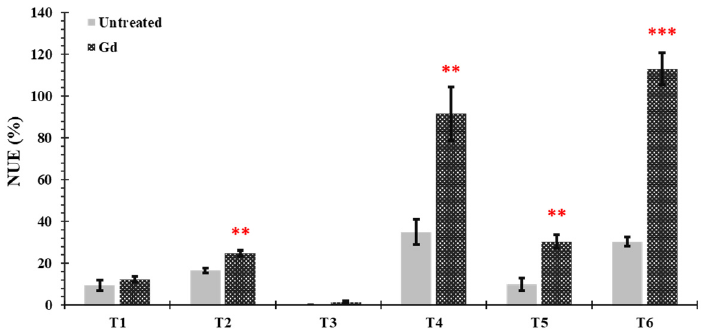
Figure 6. Evaluating the effects of severe water stress (35%-WHC; T1), moderate water stress (50%- WHC; T2), severe nitrogen stress (0 mg N pot − 1 ; T3), moderate nitrogen stress (150 mg N pot − 1 ; T4), combination of severe water stress and moderate nitrogen stress (35% WHC and 0 mg N pot − 1 ; T5), and combination of moderate water stress and moderate nitrogen stress (50% WHC and 150 mg N pot − 1 ; T6) on nitrogen use efficiency of maize plants inoculated with Gluconacetobacter diazotrophicus Pal5 (Gd) in comparison with untreated plants. Bars represented means of three ( n = 3) replicates with standard errors (SEs). ** and *** above bars indicate significance at p < 0.01 and p < 0.001, respectively. Bars without any * are non-significant ( p > 0.05).